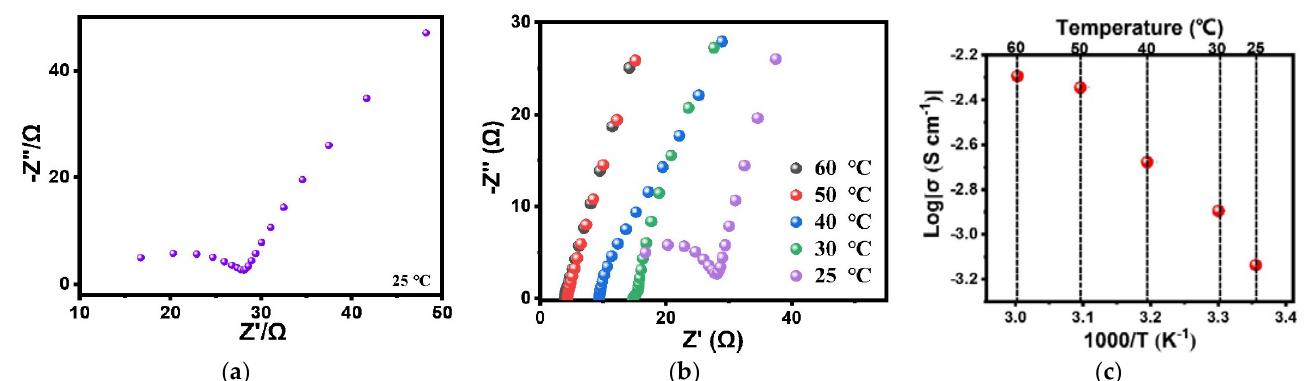
Figure 3. EIS test with SS||SS cells. ( a ) Nyquist plot of SPCE at room temperature. ( b ) Nyquist and ( c ) Arrhenius plots of SPCE at different temperatures (25, 30, 40, 50, and 60 °C).